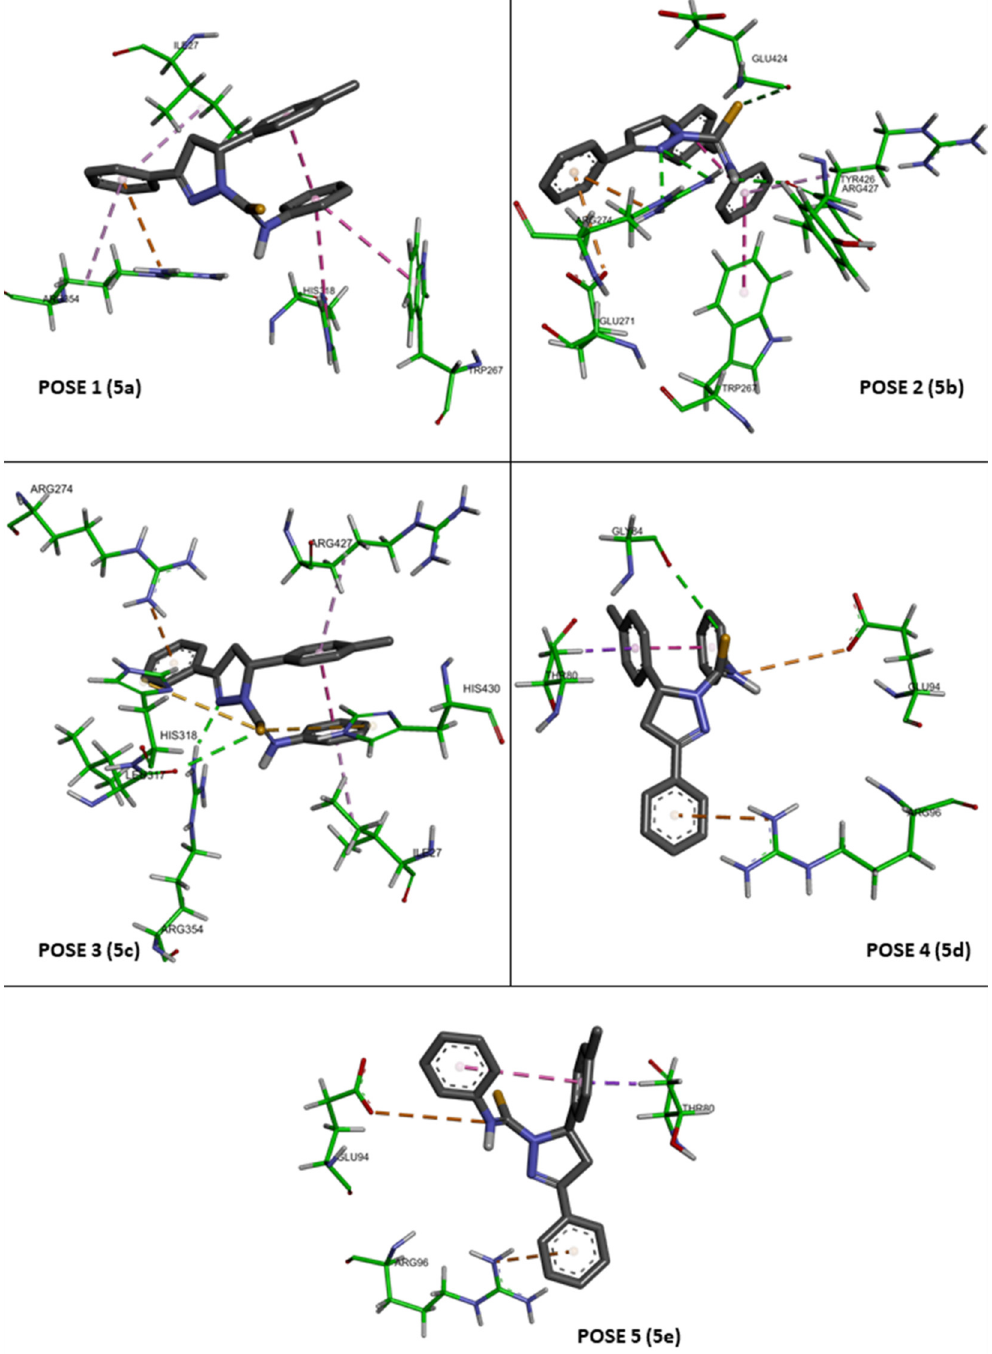
Figure 5. Three-dimensional binding modes of compound 4a (pose 1–5) present at the active sites of CYP51. The interaction modes of the most potent pose in CYP51: Figure 5a orientation 4a in pose 1, Figure 5b orientation 4a in pose 2, Figure 5c orientation 4a in pose 3, Figure 5d orientation 4a in pose 4 and Figure 5e orientation 4a in pose 5. Pi-cation/Pi-anion/attractive charge interactions (orange), Pi-sigma interaction (purple), Pi-sulfur (light brown), conventional hydrogen bond interaction (green), unfavorable interaction (red), Pi-Pi T-shaped interaction (pink).